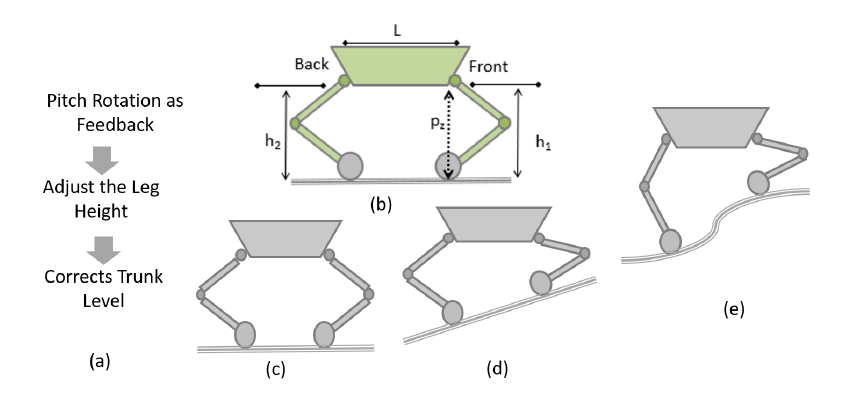
Figure 11. ( a ) Steps for trunk level correction. ( b ) Schematic of leg height. ( c – e ) Stable positions of the platform on different terrain